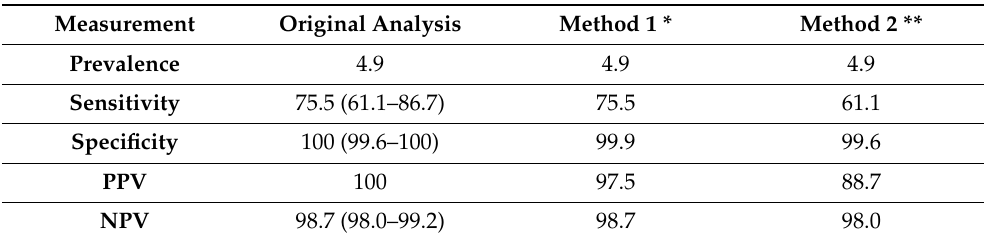
Table 2. Estimated sensitivity and specificity based on the original analysis and alternative methods explored.